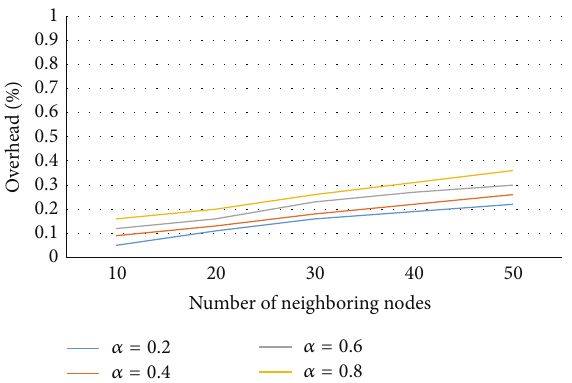
Figure 14: Degree of congestion when transmission rate is varied.